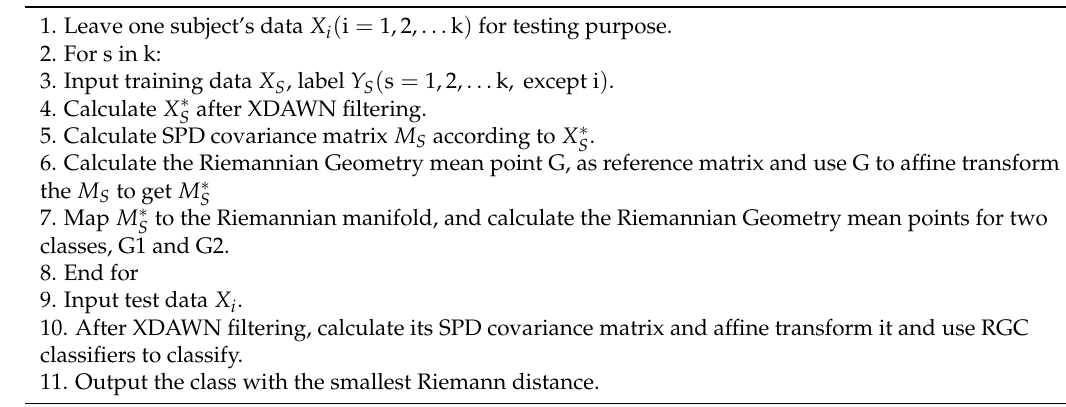
Table 1. Algorithm of experiment 1.